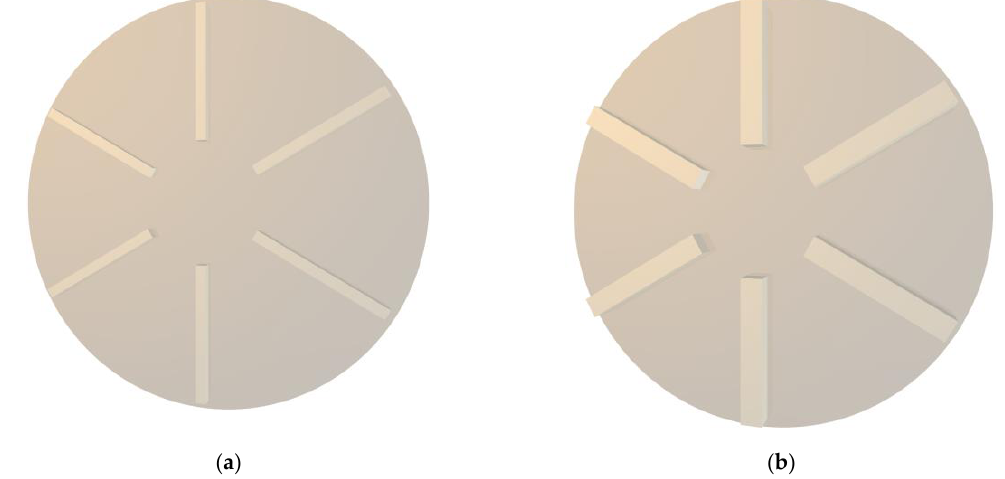
Figure 8. Simulation of 25 mm × 25 mm end liner compared with 50 mm × 50 mm end liner. ( a ) 25 mm × 25 mm end liners, power draw = 2211 W, % energy loss due tofriction 47.33. ( b ) 50 mm × 50 mm end liners, power draw = 2114 W, % energy loss due to friction 46.08.